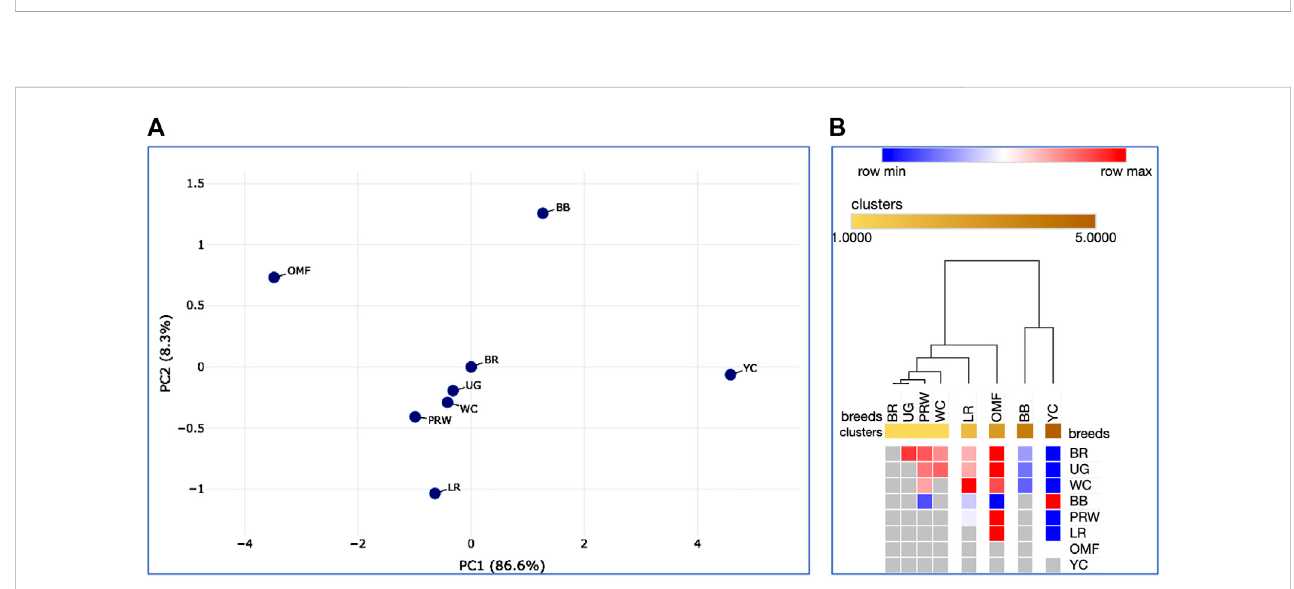
FIGURE 9 Analysis of thedistributionof theeight breeds for 21 traits (DGE ofmyogenesis associated genes and NO metabolism in embryos,as well as indicators of early chick growth) performed in the Phantasus program (Zenkova et al., 2018). (A) PCA plot. X and Y -axes show principal component 1 (PC1) and principal component 2 (PC2) that explain 86.6% and 8.3% of the total variance, respectively. N = 8 data points (breeds). (B) Heatmap and hierarchical clustering tree based on Euclidean distance metric (with the average option as linkage